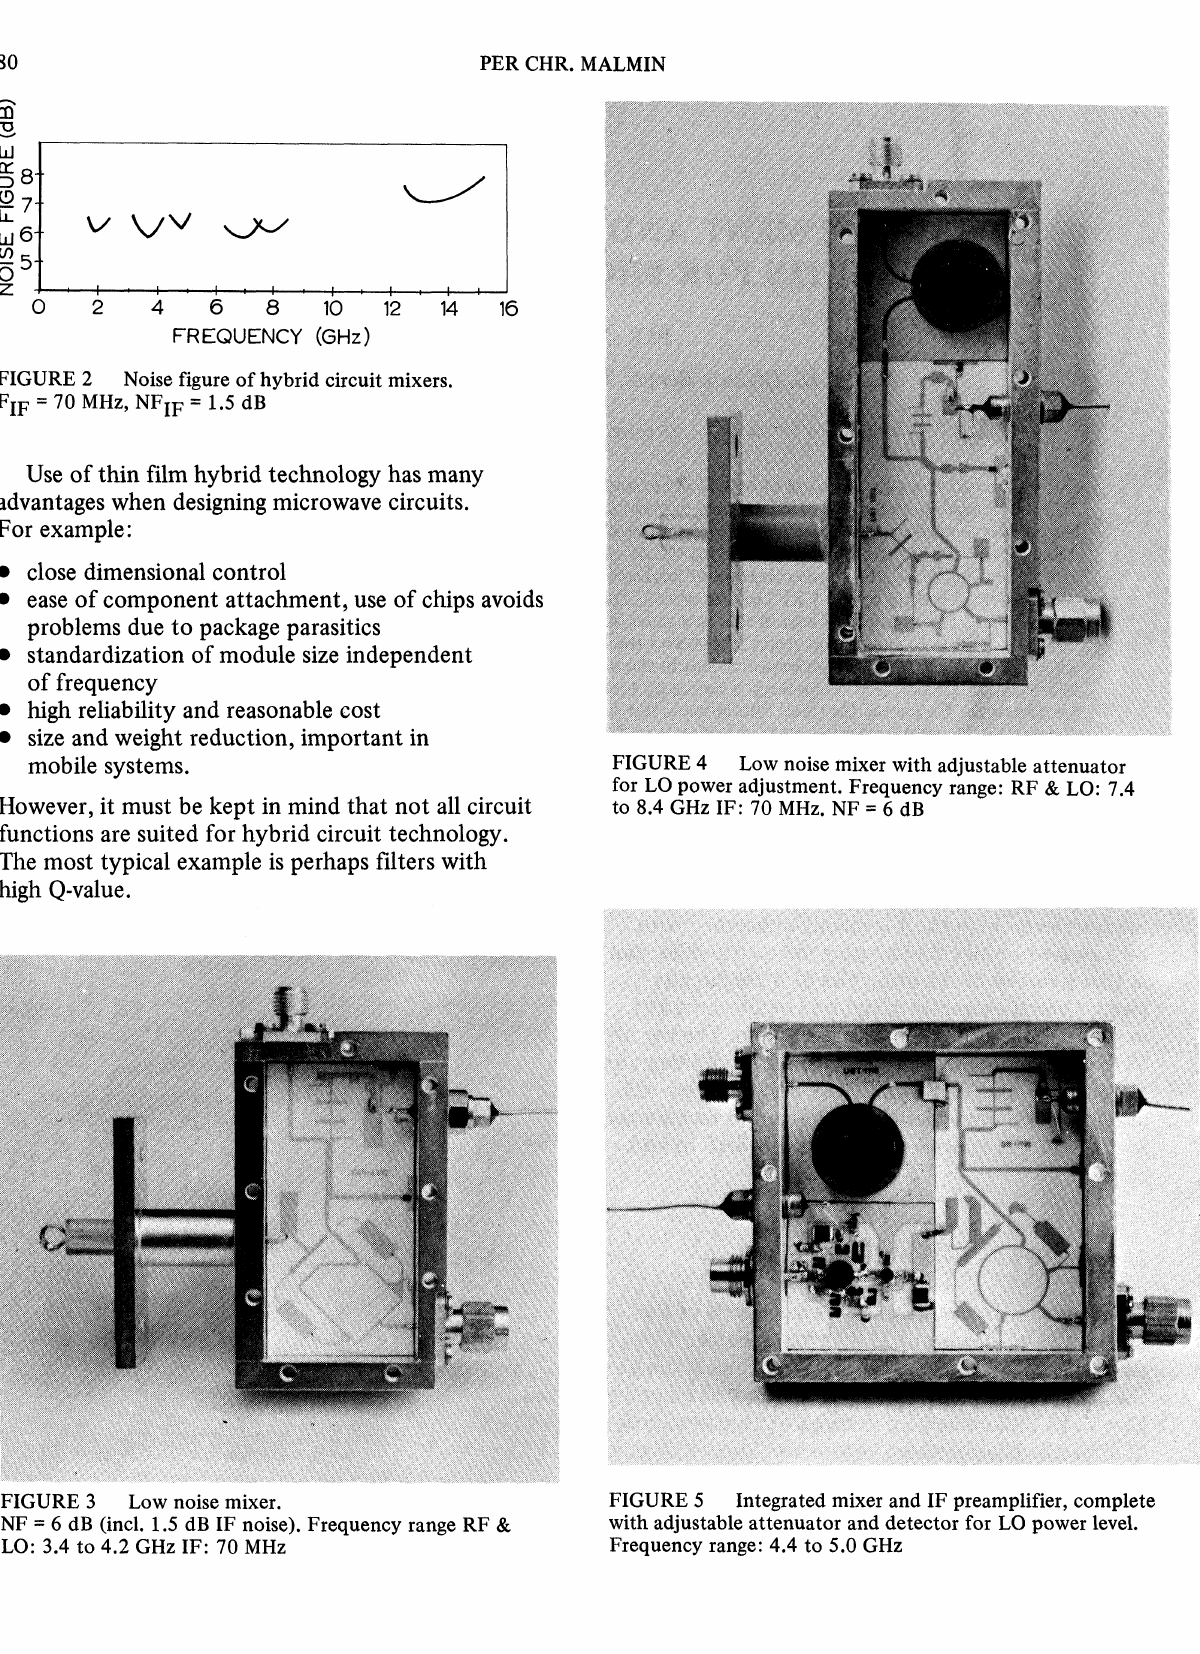
Integrated mixer and IF preamplifier, complete with adjustable attenuator and detector for LO power level. Frequency range: 4.4 to 5.0